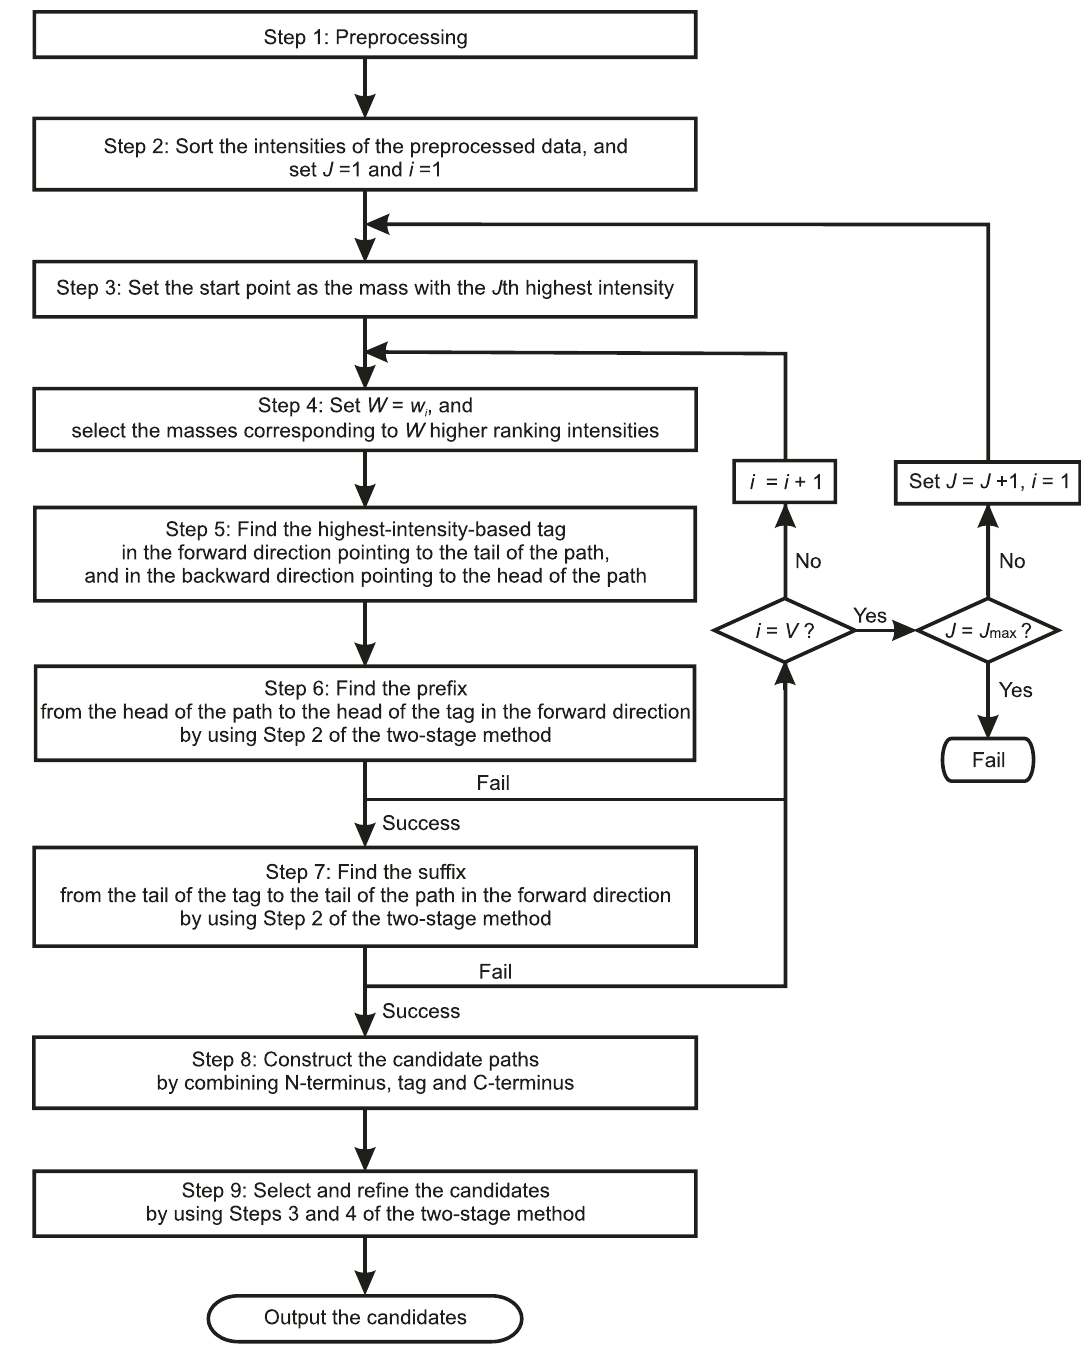
Fig. 4 A fl owchart illustrating the method of highest-intensity-tag based sequencing. i represents the iteration number and V is the maximum number of iterations. W represents the number of masses with the higher ranking used in the tag- fi nding processing and w i is the number of masses with the higher ranking for the i th iteration. J represents the ranking of intensity and J max is the maximum number of higher-ranking-intensity masses allowed to be the start point to fi nd the